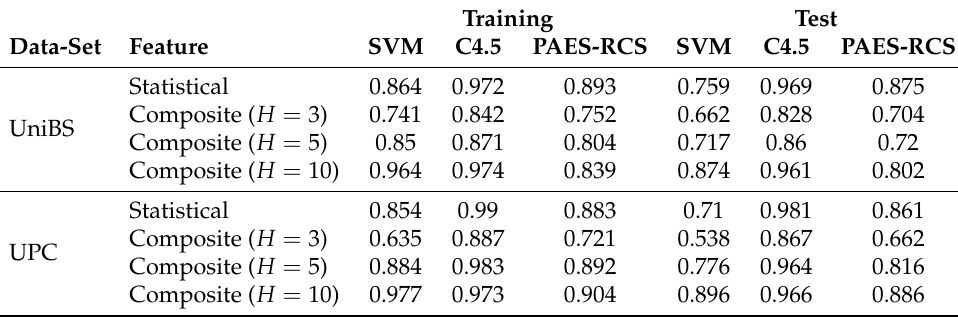
Table 19. Performance comparison: Accuracy (for the PAES-RCS algorithm the First solution has been considered).